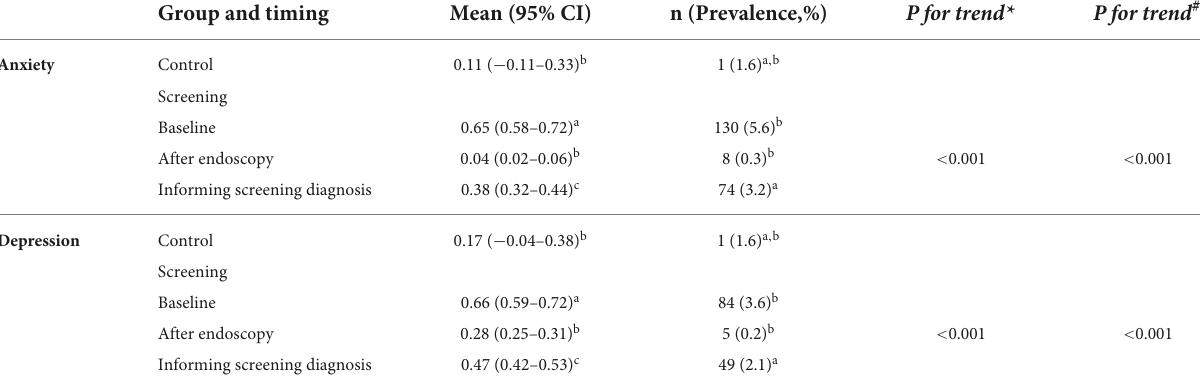
TABLE 1 Anxiety and depression in the screening